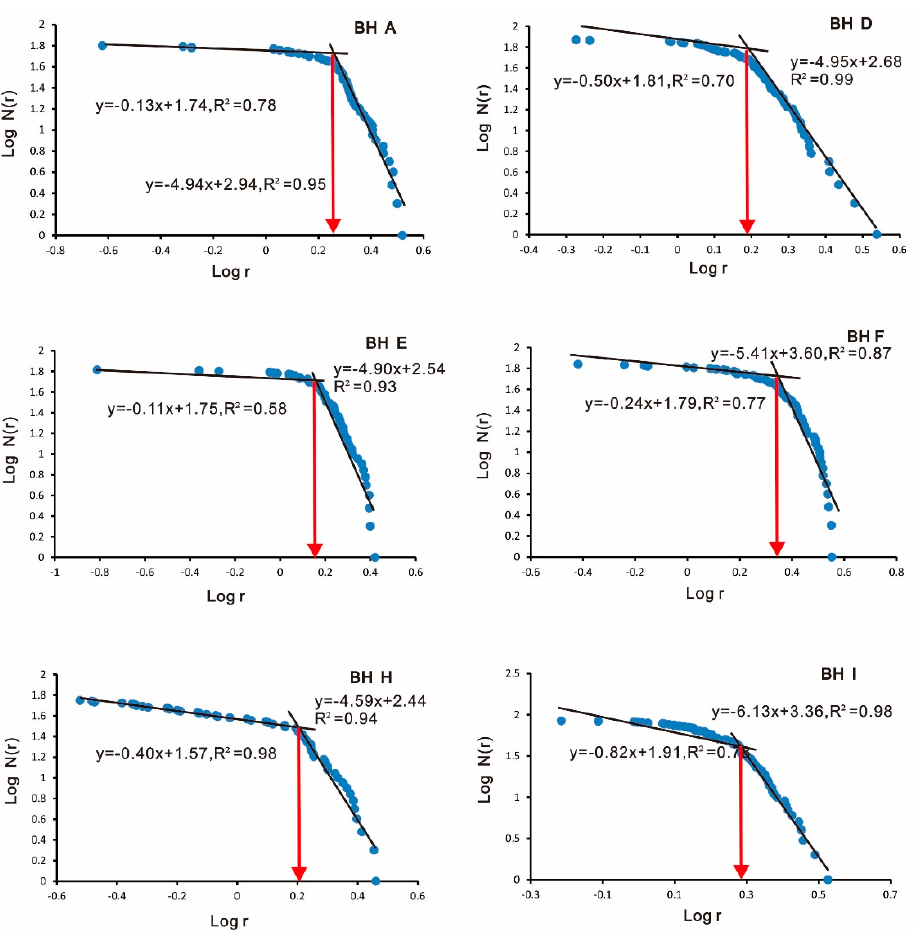
Figure 5. Relationship between the fractal dimension and the coefficient of variation.